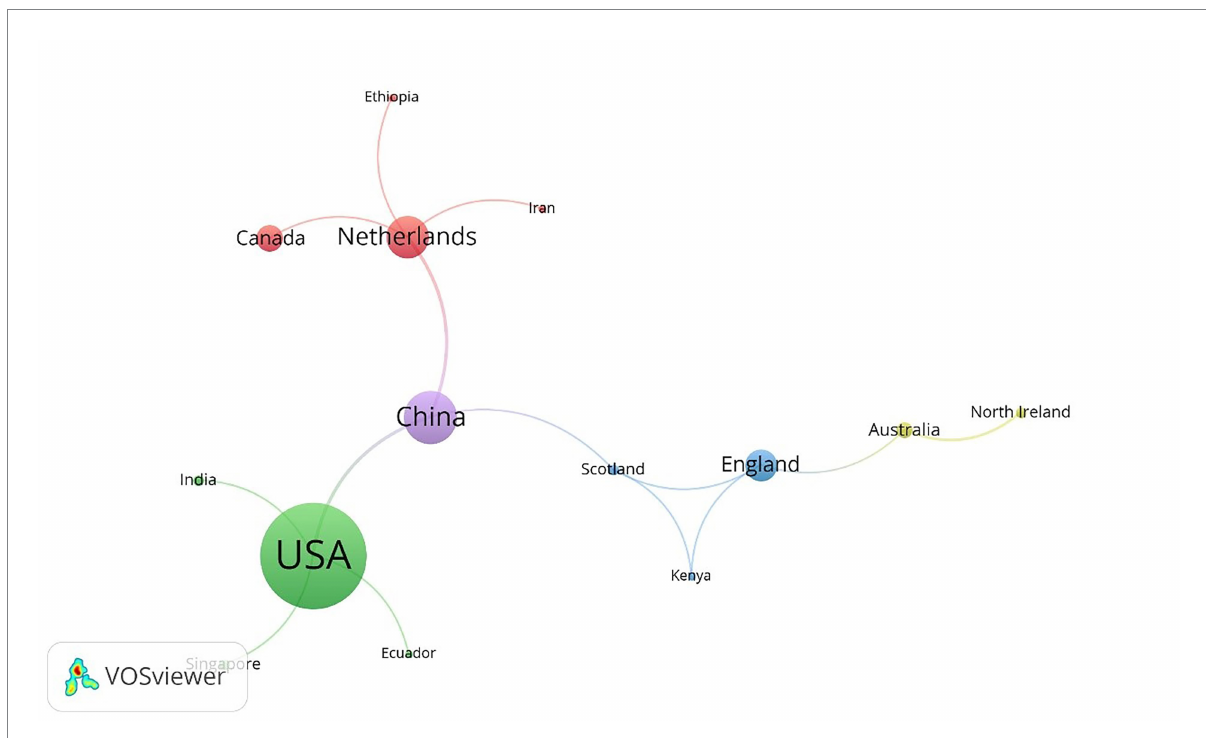
FIGURE 6 Map of countries actively engaged in this research